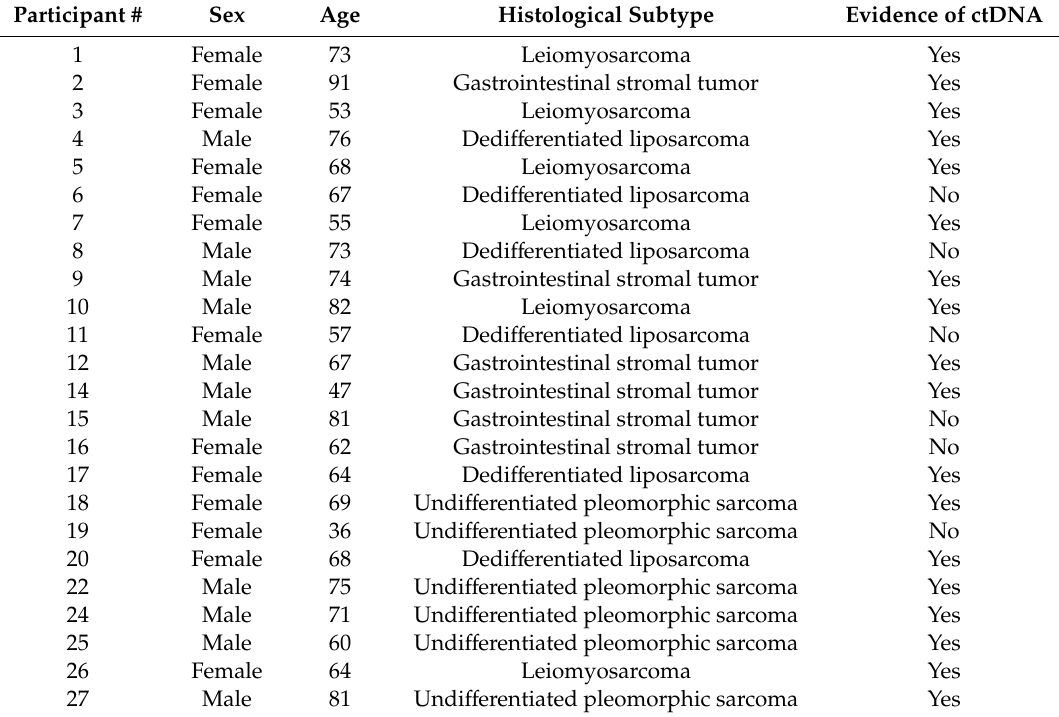
Table 1. Subject demographics. Twenty-seven subjects were enrolled—three subjects failed to complete